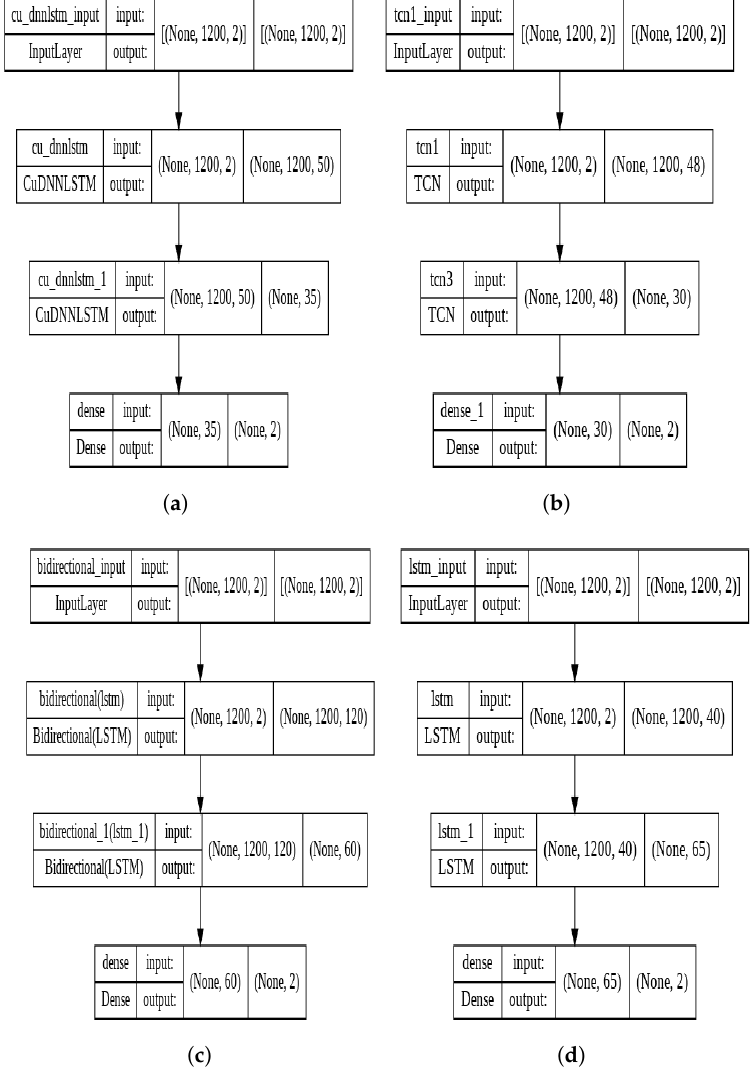
Figure 3. The architecture of models. ( a ) CudNN-LSTM Model Architecture. ( b ) TCN Model Architecture. ( c ) BI-LSTM Model Architecture. ( d ) LSTM Model